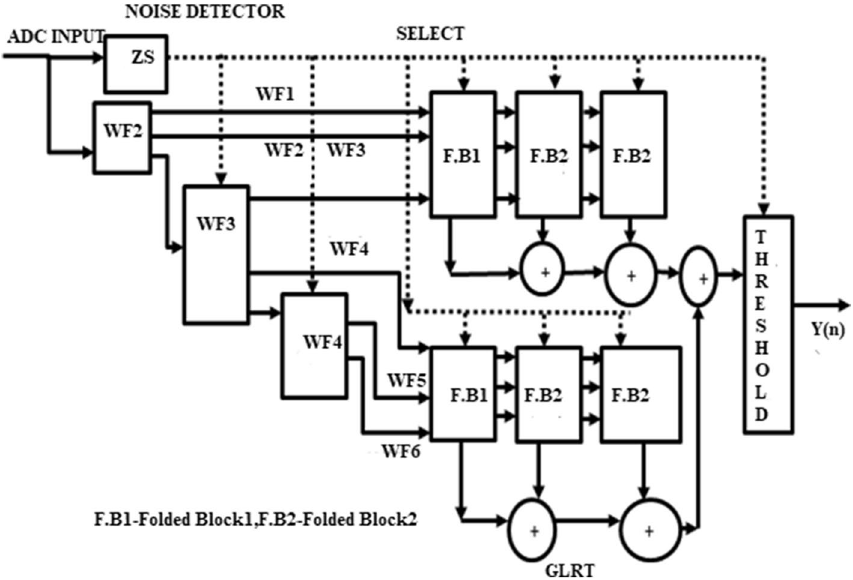
Figure 11. Modified Folded undecimator based ECG